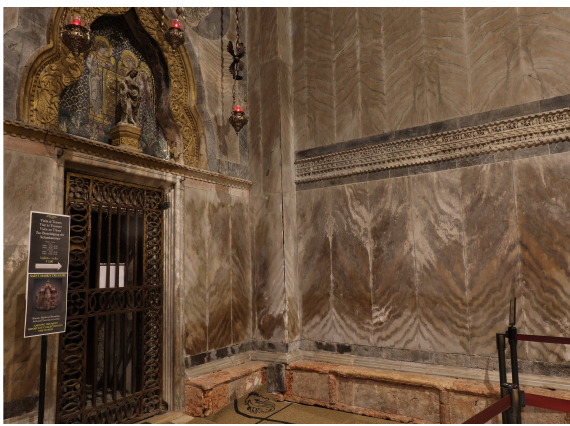
Figure 2. San Marco Basilica, south transept, marble decoration.